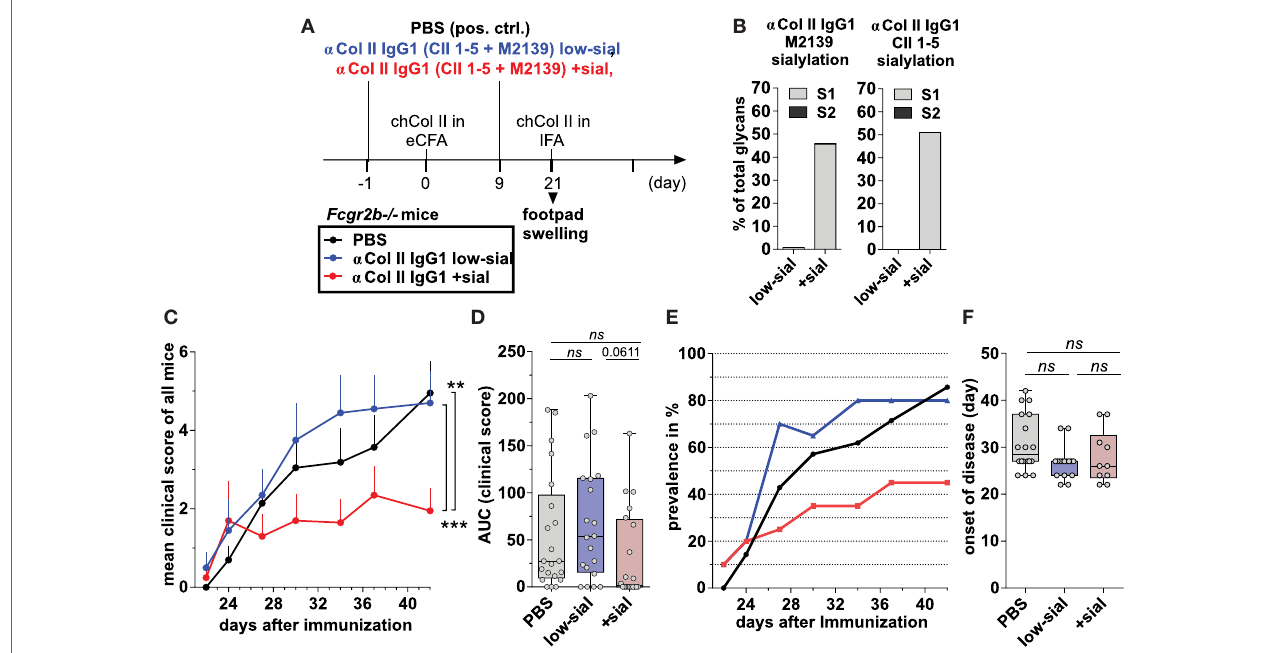
FigUre 5 | Sialylated collagen type II (Col II)-reactive monoclonal IgG antibodies (Abs) suppress collagen-induced arthritis (CIA). (a) Graphical representation of the experimental strategy. CIA was induced in Fcgr2b − / − mice by subcutaneous injection of Col II in enriched CFA (eCFA) and subsequent challenge with Col II in incomplete Freund’s adjuvant (IFA) on day 21. One day before and 9 days after the first immunization, the mice received 100 µg of either low-sialylated (low-sial) or in vitro galactosylated plus sialylated ( + sial) anti-Col II murine IgG1 Abs (clones M2139 and CII 1–5; 50 µg each) The positive control group received PBS instead